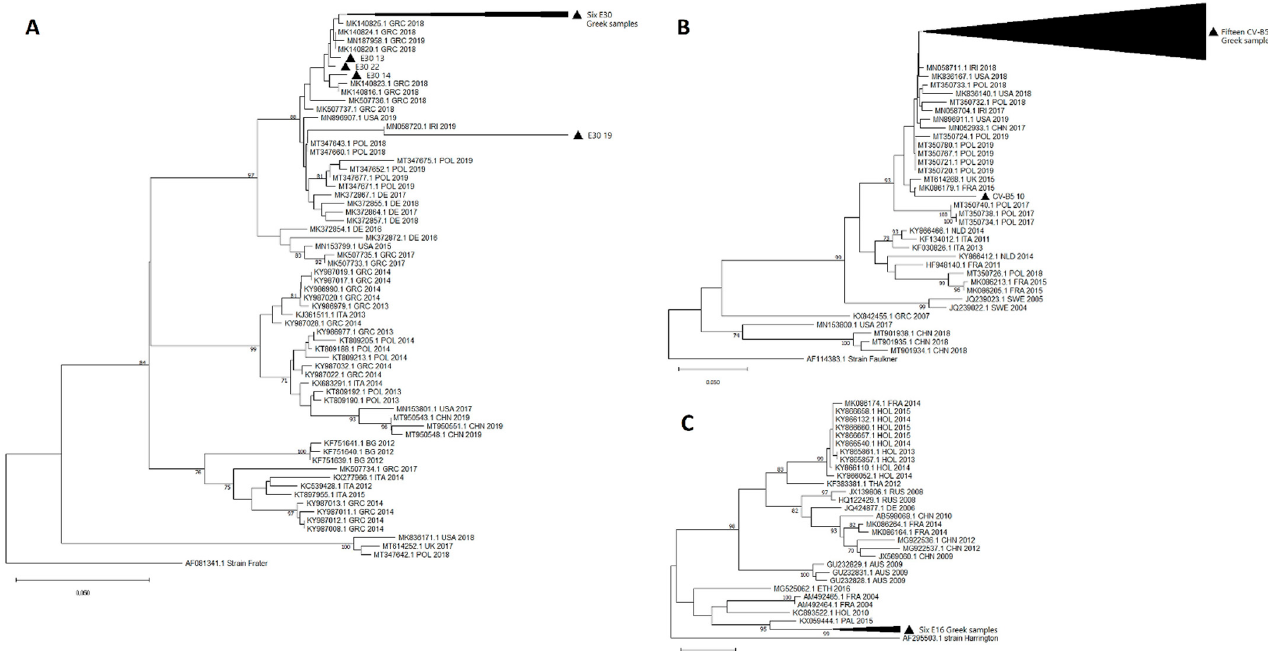
Figure 3. Phylogenetic trees of E30 (A), CV-B5 (B) and E16 (C) strains of this study with other global reference strains based on a part of 308, 274 and 295nt of the VP1 gene, respectively. Greek strains of this study are indicated with a filled black triangle. Outgroups are indicated by name and accession number from GenBank. The rest of the reference strains are labeled with the accession number, 2 or 3 letters of the country of origin and the year of isolation. The neighbor-joining method and bootstrap test of 1000 replicates were used to infer the phylogenetic trees. Only percentage values of replicate trees above 70% are shown next to branches. Notes: GRC = Greece; HOL = Holland; POL = Poland; DE = Germany; FRA = France; ITA = Italy; UK = United Kingdom; BG = Bulgaria; AUS = Australia; RUS = Russia; CHN = China; THA = Thailand; PAL = Palestine; IRI = Iran; ETH = Ethiopia.